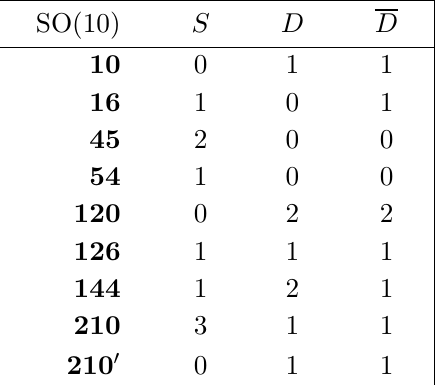
Table 12 . Number of SM singlets and weak doublets contained in the lowest dimensional irreducible representations of SO(10), according to the decompositions in tables 10 and 11. The labels S , D and D indicate the representations ( 1 ; 1 ; 0), ( 1 ; 2 ; + 1 ) and ( 1 ; 2 ; (cid:0) 1 ) of the SM gauge group G 321 . 2 2 are 10 , 120 or 126 and it contains (some part of) the MSSM Higgs doublet/antidoublet ( 1 ; 2 ; (cid:6) 1 = 2) with an EW scale VEV, cf. section 3. Furthermore, the n + n 0